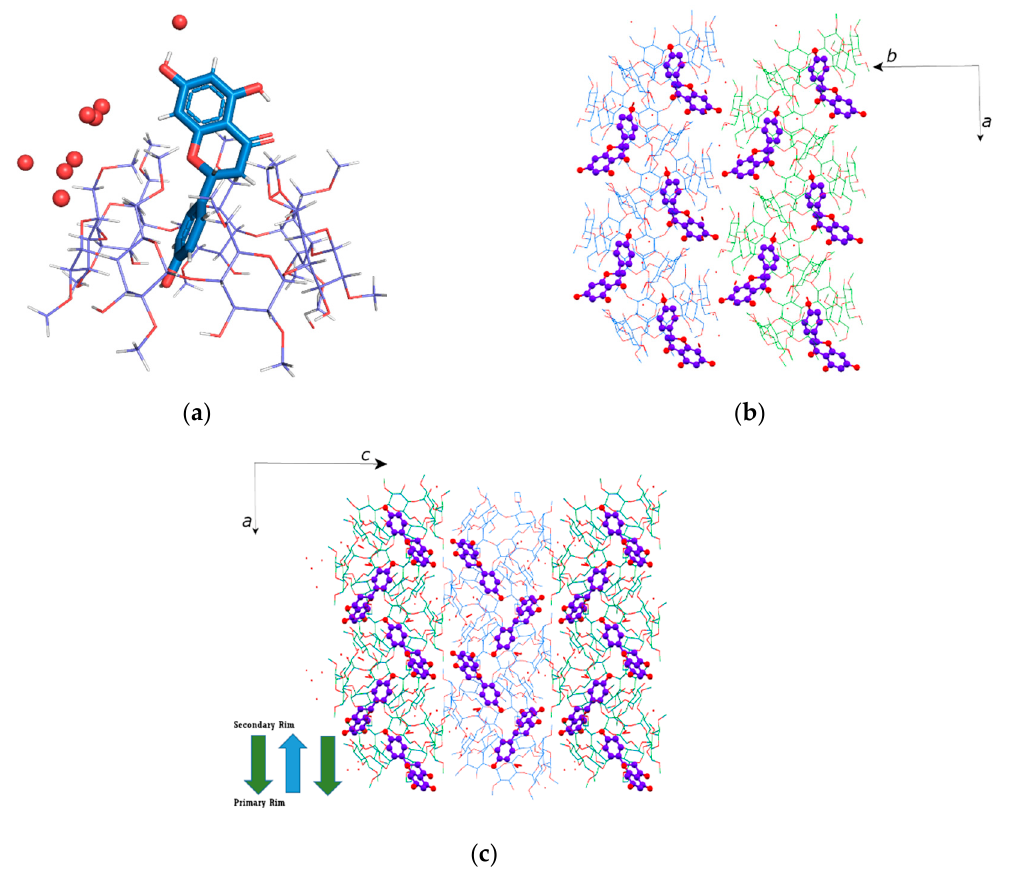
Figure 2. ( a ) The asymmetric unit of the naringenin/DM- β -CD inclusion complex crystal structure. One guest molecule is partially encapsulated inside the host’s cavity with its 4-hydroxyphenyl residue (ring B) entering from its primary rim; ( b ) complex units are packed in a ‘herring bone’ fashion along the a -axis. These columns are deployed parallel along the b -axis ( ab -plane projection); and (c) anti-parallel along the c -axis ( ac -plane projection).